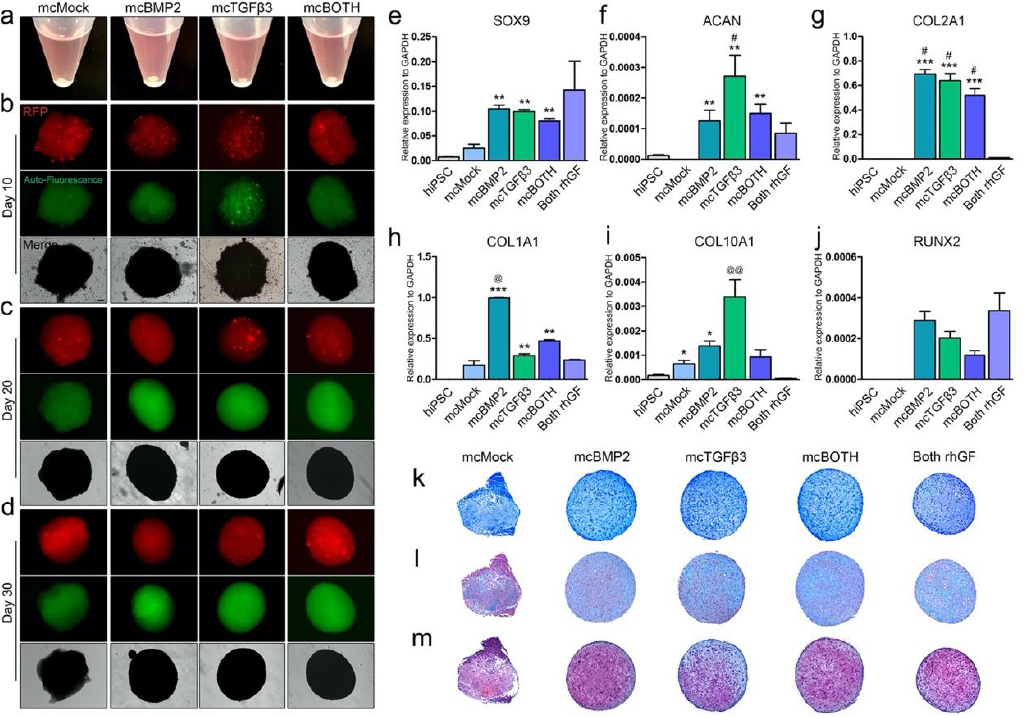
Figure 3. Minicircle expression in chondrogenic pellets and characterization of the generated pellets. ( a ) Morphology of pellets generated from hiPSC-derived OG cells on day 3. Fluorescence image of the chondrogenic pellets on ( b ) day 10, ( c ) 20, and ( d ) 30 of differentiation. Minicircle vectors were detected with RFP expression. GFP was detected to consider the auto-fluorescence of three-dimensional pellets. ( e ) Relative gene expression of SOX9 in chondrogenic pellets. ( f ) Relative gene expression of ACAN. ( g ) Relative gene expression of COL2A1. ( h ) Relative gene expression of COL1A1. ( i ) Relative gene expression of COL10A1. ( j ) Relative gene expression of the osteogenic marker, RUNX2. Data are presented as mean ± standard deviation from three independent sets of experiments. Each experiment analyzed 5 pellets per group. ( k ) Toluidine blue staining image of chondrogenic pellets. ( l ) Alcian blue staining of chondrogenic pellets for ECM detection. ( m ) Safranin O staining image of chondrogenic pellets. * p < 0.05; ** p < 0.01; *** p < 0.001 vs. mcMock (t-test), # p < 0.05 vs. mcMock, @ p < 0.05; @@ p < 0.01 vs. Both rhGF (one-way Anova) indicate significance. mcMock: minicircle mock vector-transfected outgrowth cells; mcBMP2: minicircle BMP2-encoding vector-transfected outgrowth cells; mcTGF β 3: minicircle TGF β 3-encoding vector-transfected outgrowth cells; mcBOTH: 1:1 mixture of mcBMP2- and mc TGF β 3-transfected outgrowth cells; Both rhGF: both recombinant human BMP2 and TGF β 3 growth factor protein-treated outgrowth cells.